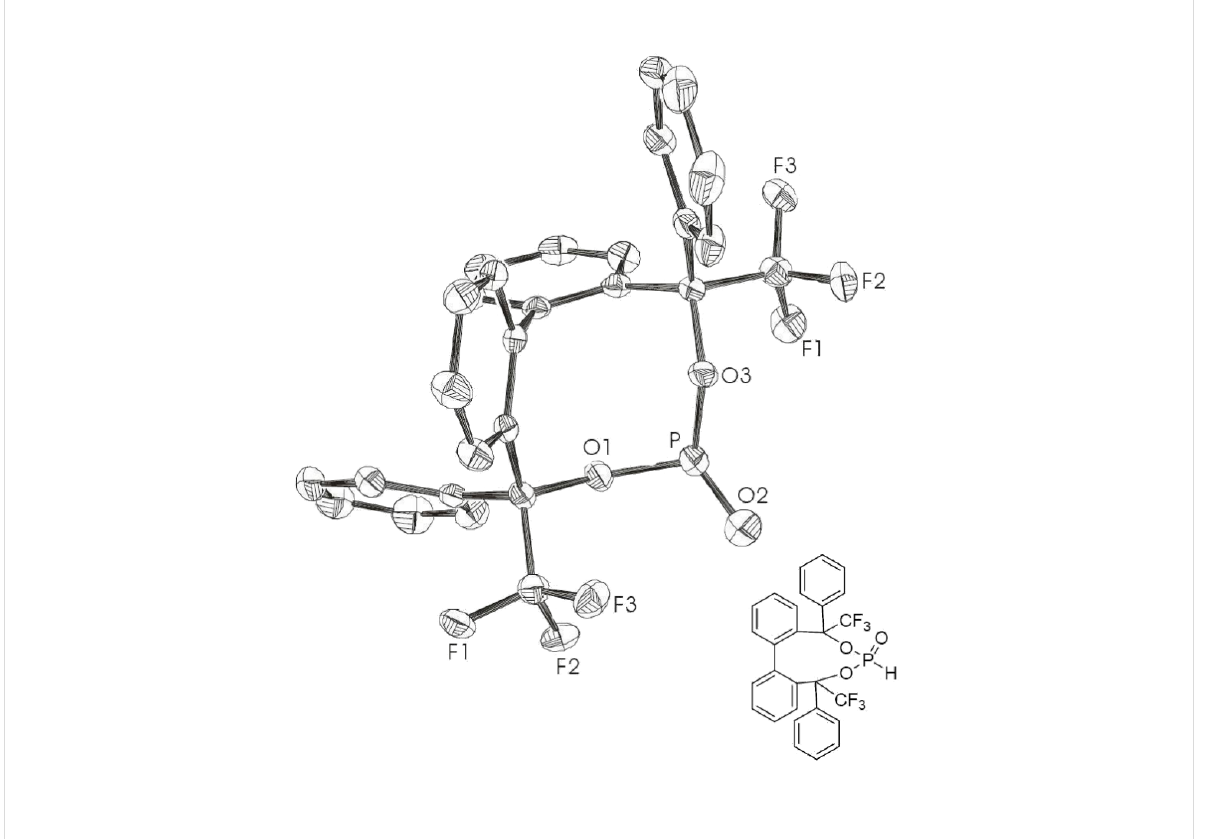
Figure 4: X-ray crystal structure of 15 . ( M ) - ( R,S ) diastereomer; ellipsoids correspond to 50% probability levels. Hydrogen atoms are omitted for clarity.